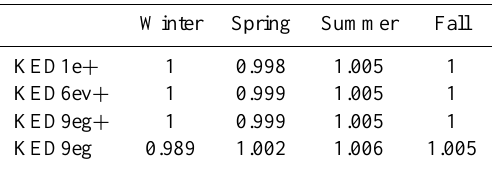
Table 6. Relative bias B calculated over all stations for different seasons using different interpolation models (see Table 1 for model acronyms).